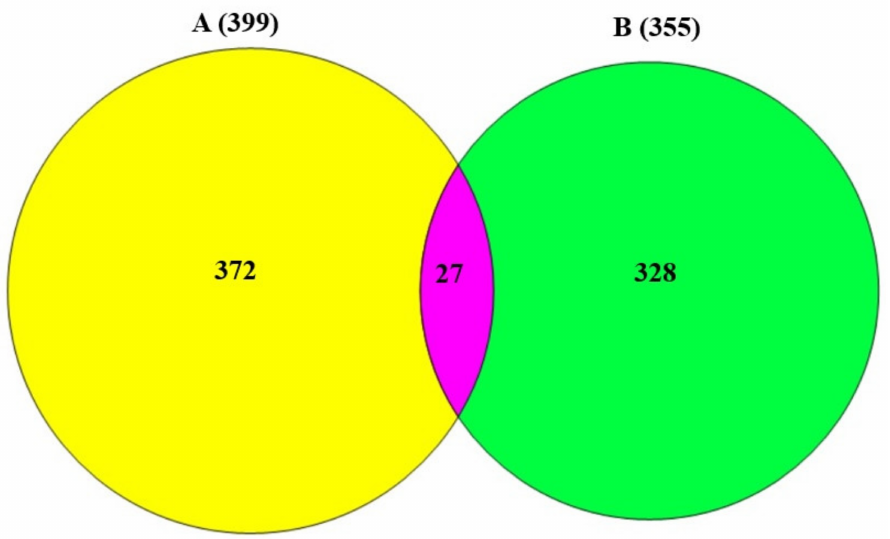
Figure 3. Overlapping genes between 399 overlapping genes from two databases ( A ) and COVID-19- related genes (356 genes) ( B ). * Both human and mouse ACE2 gene included in Venn diagram, thus indicating a total of 355 genes ( B